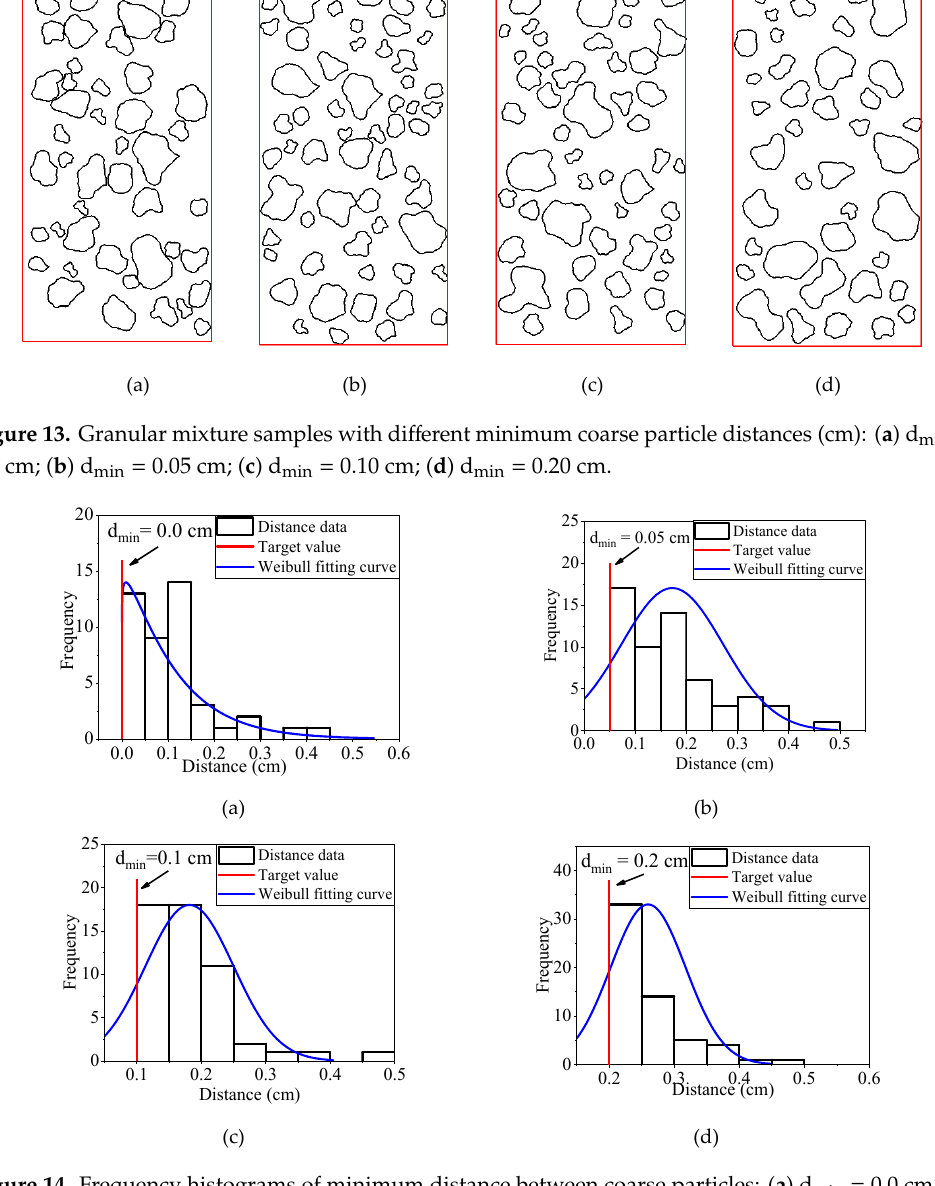
Figure 14. Frequency histograms of minimum distance between coarse particles: ( a ) d min = 0.0 cm; ( b ) d min = 0.05 cm; ( c ) d min = 0.10 cm; ( d ) d min = 0.20 cm.